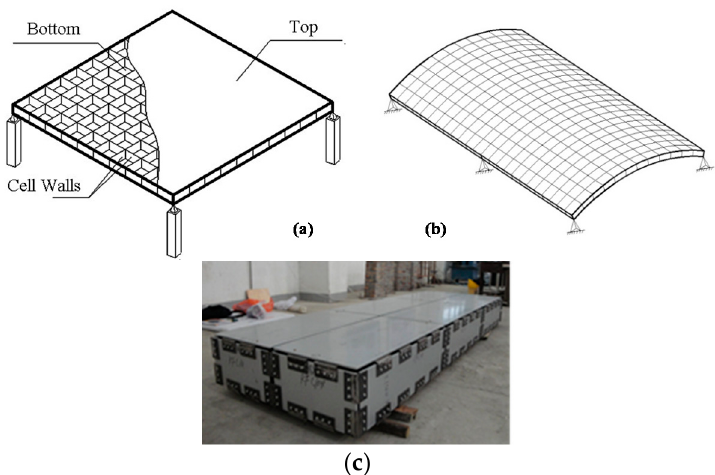
Figure 1. Typical long-span hollow core roofs formed by honeycomb panels: ( a ) flat type; ( b ) curved type; ( c ) assembly unit.